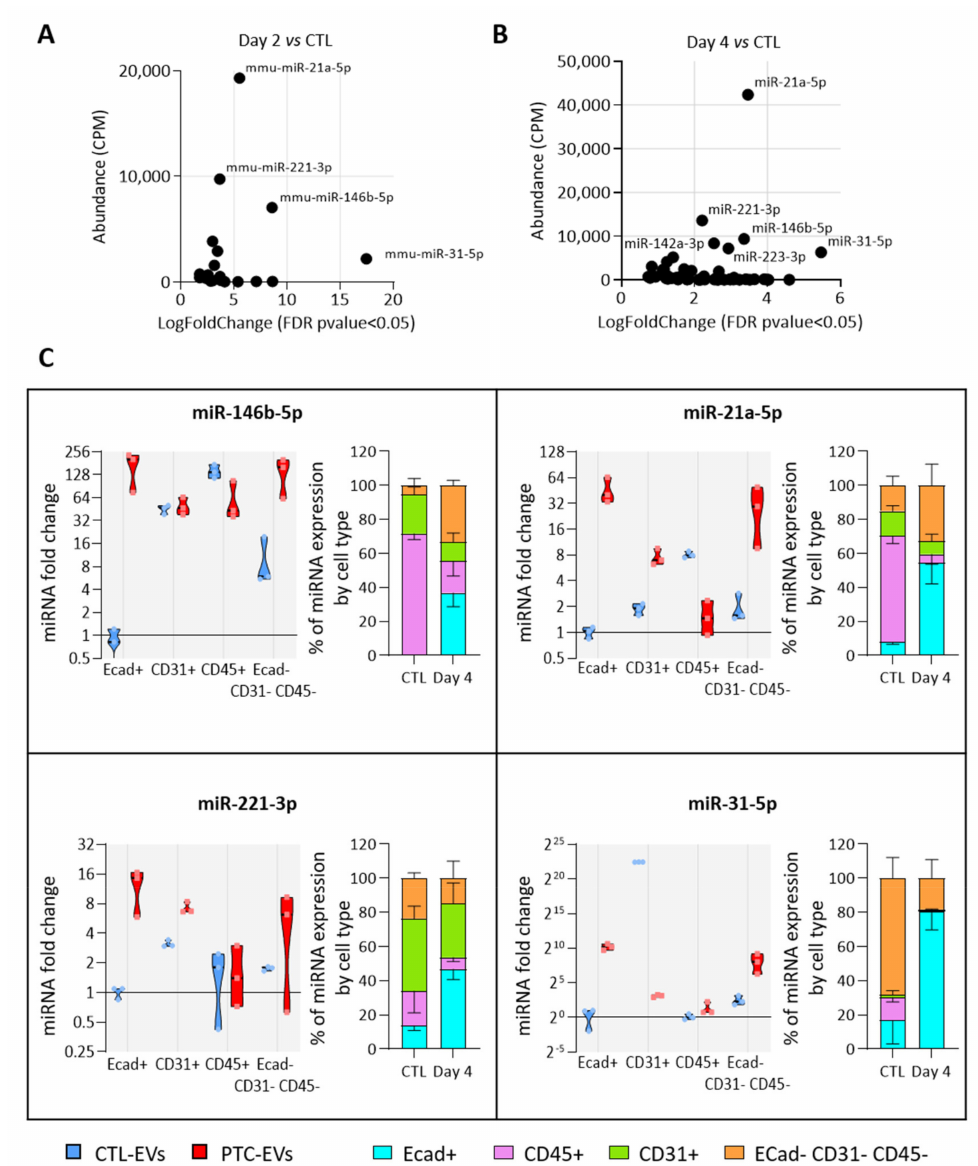
Figure 5. The most deregulated and most abundant EV-miRNAs are mainly expressed and dereg- ulated in epithelial cells. ( A , B ) Scatter plots showing abundance (CPM calculated from miRNA sequencing data) of statistically deregulated EV-miRNAs between the control and DOX-treated tissues at day 2 ( A ) and day 4 ( B ). ( C ) RT-qPCR analyses of miRNA expression in FACS-sorted cell populations (n = 4). Violin plots show miRNA fold changes normalized on the abundance of a spike-in miRNA and compared to its expression in the epithelial population of control thyroids. Stacked bars show the relative expression (in percent) of miRNAs in each population of control and DOX-treated tissues. Data are expressed as the mean ±